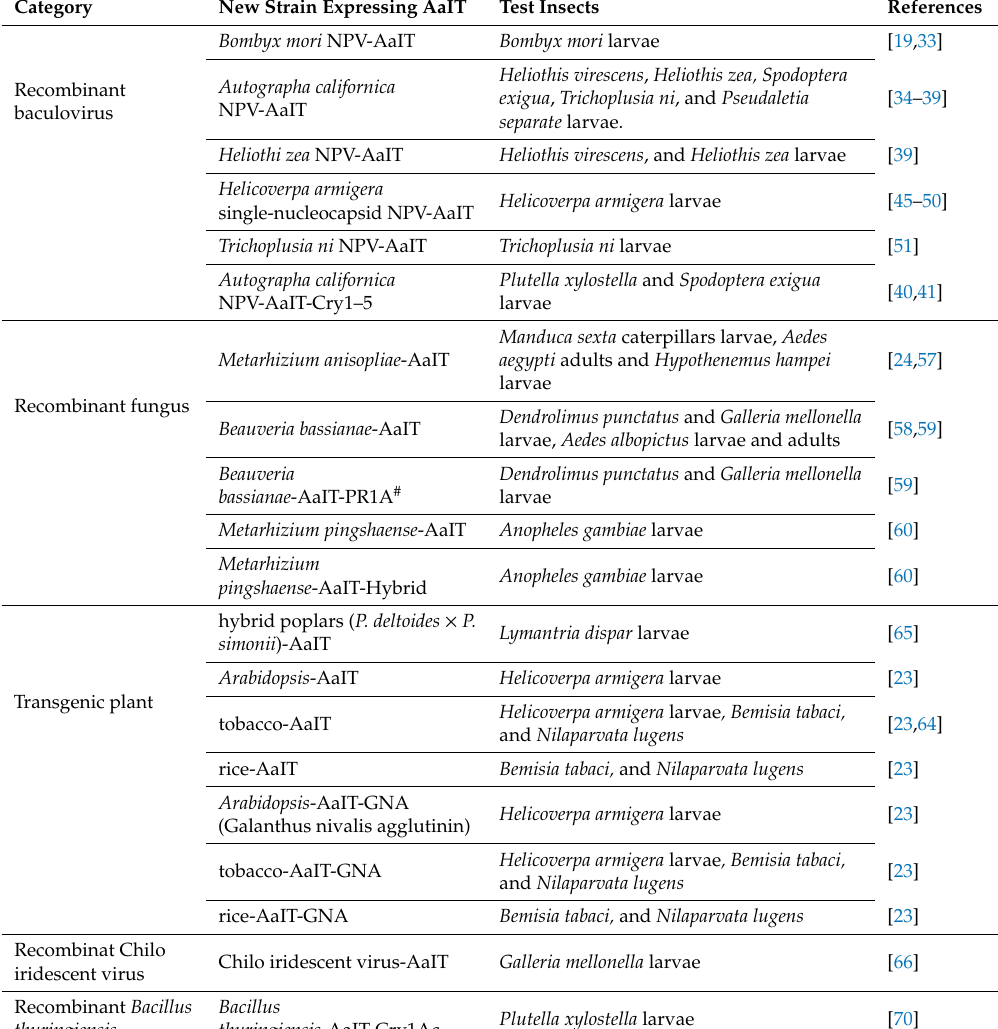
Table 2. Application of AaIT against insect